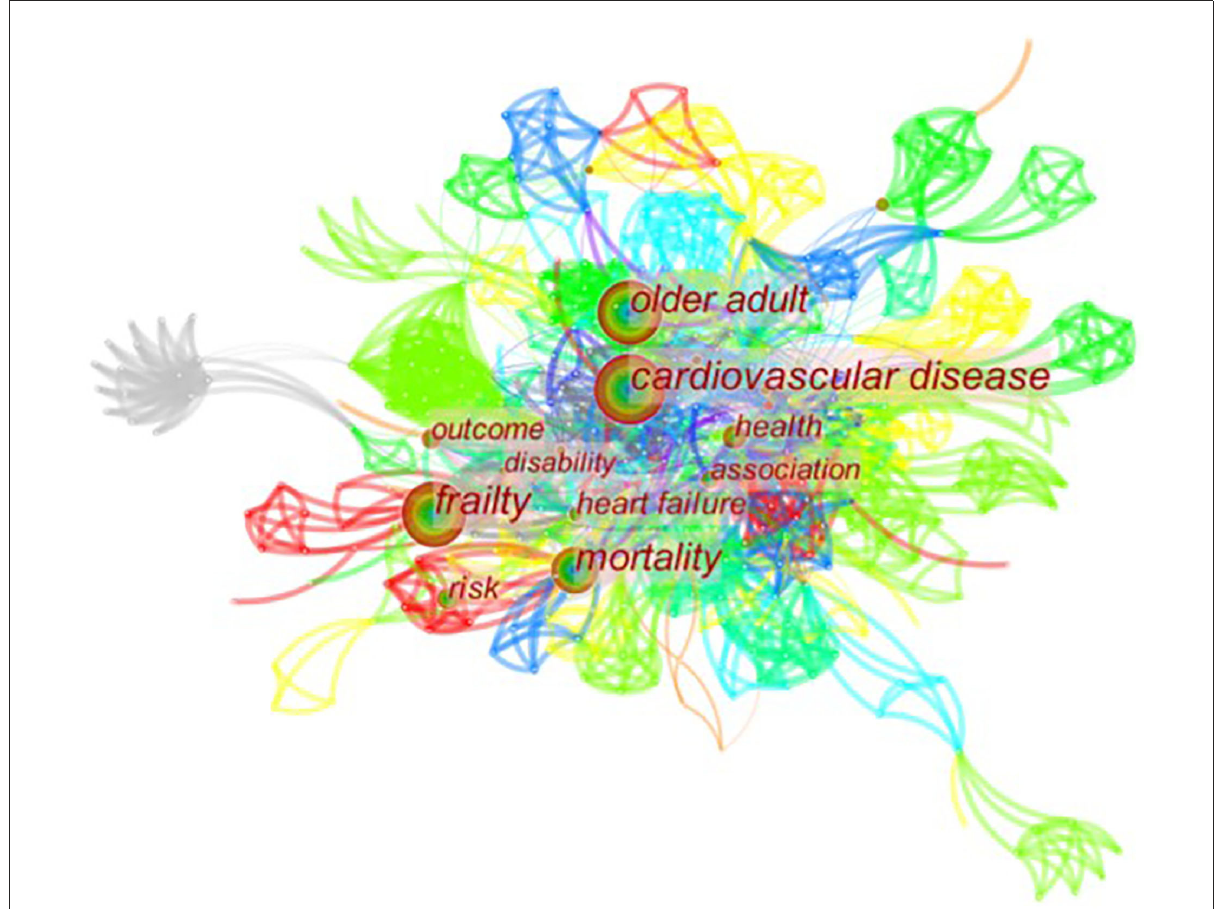
FIGURE6 Map of keywords related to CVD with frailty from 2000 to 2021.